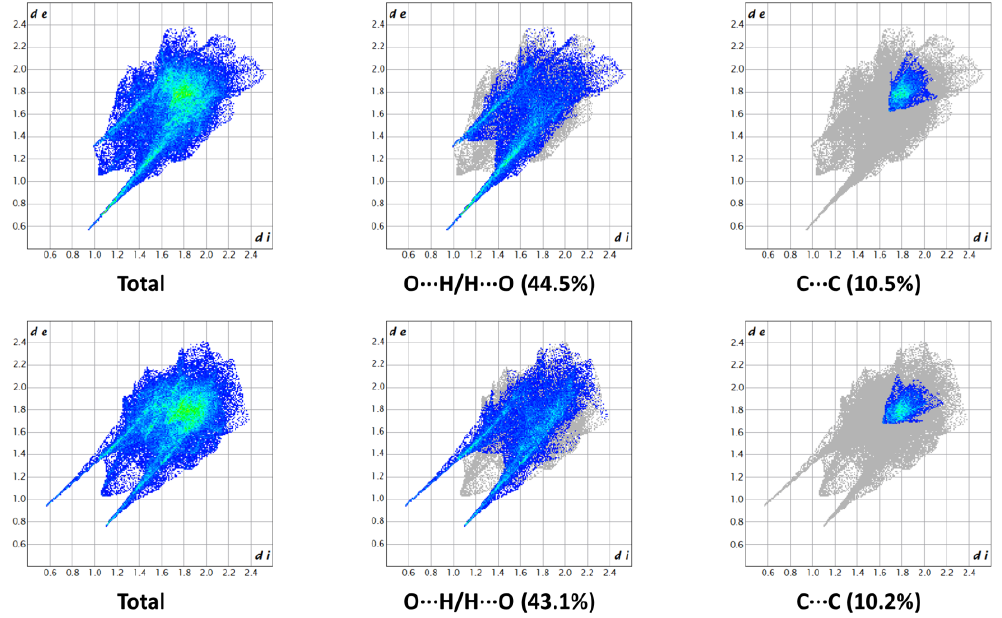
Figure 4. Main 2D fingerprint plots of the HSs of 1 (above: main molecule; below: molecule A). the graphical representation provides a summary of the frequency of each combination of d e and d i across the HS. Points with a lower contribution to the surface are colored blue, while green indicates a larger contribution.